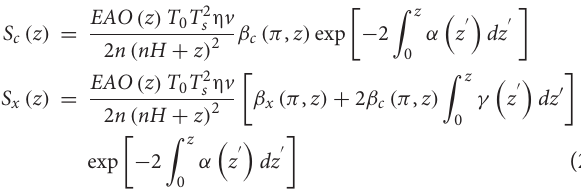
The same DIAL equations can also be used to detect soft (macro)algal targets on benthic or cryospheric (ice bottom) substrates, e.g., from a lidar mounted on an AUV. Rehm et al. (2018) show the ability to detect a soft macroalgal target at 10 m ( Sargassum sp.) using this differential absorption